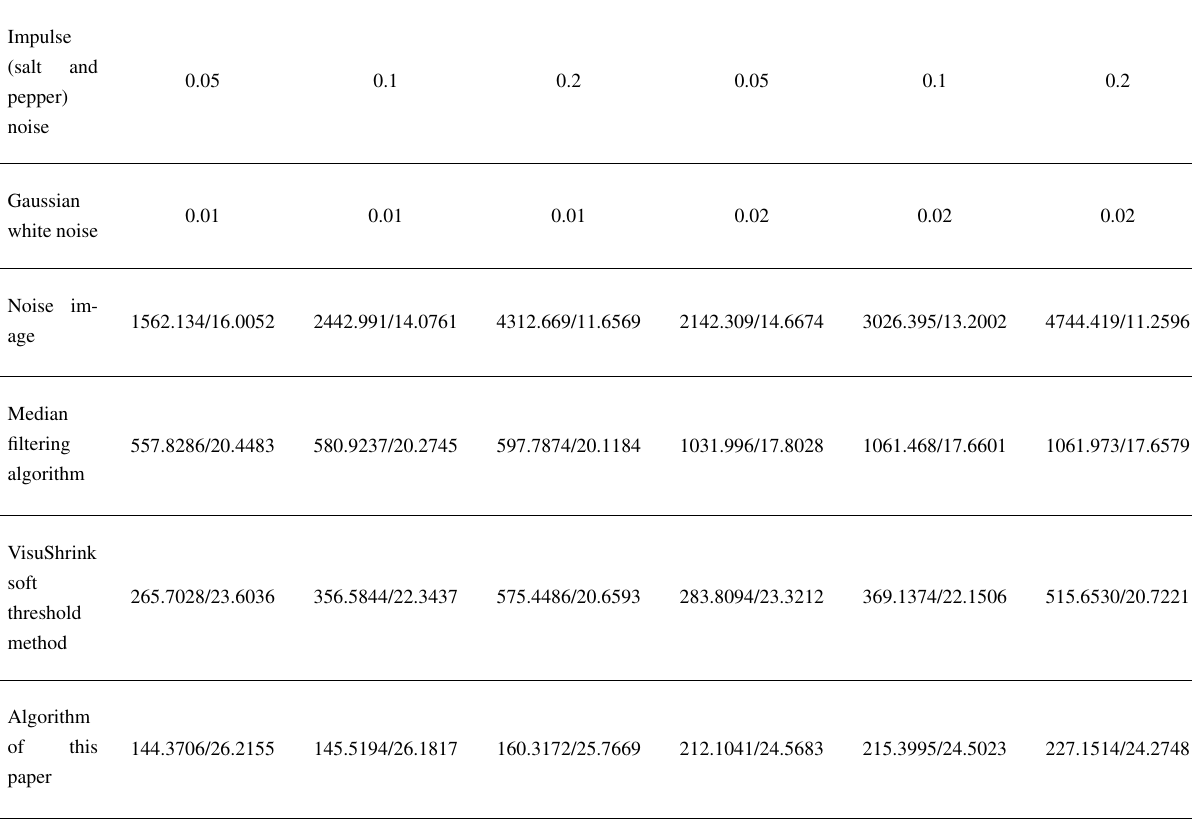
Table 1 Experimental results of the denoising of the FEI image with mixed noise by different algorithms